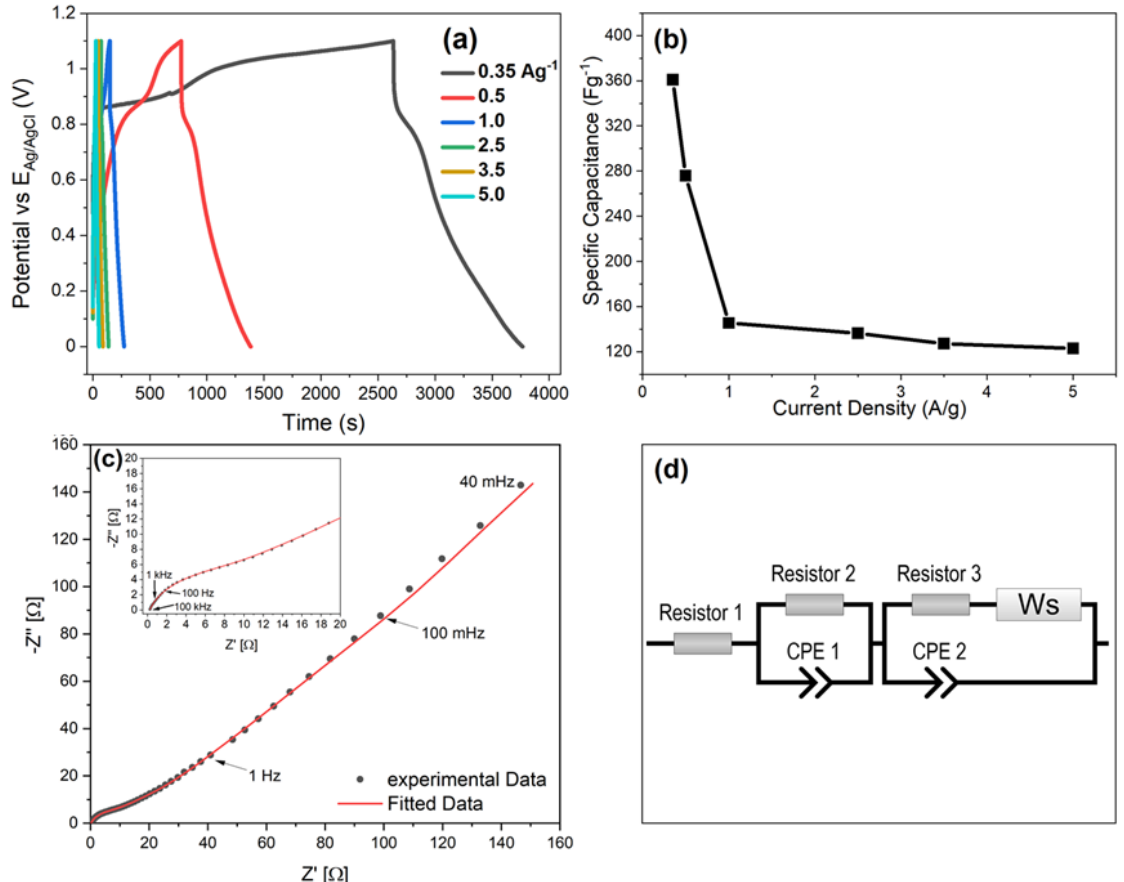
Figure 7. ( a ) Galvanostatic charge ‐ discharge plots and ( b ) specific capacitance as a function of current density, and ( c ) EIS; Inset: EIS of Pbp@HD between 100 kHz and 40 mHz, and ( d ) electrochemical equivalent circuit (CPE = constant phase element, Ws = short Warburg Diffusion).